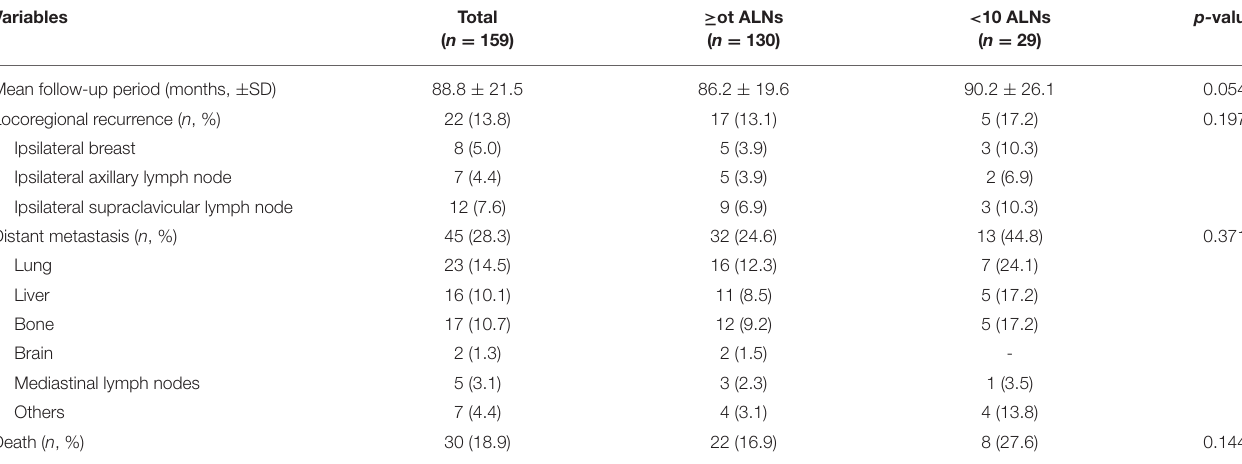
< 10 ALNs p- value ( n = 29)